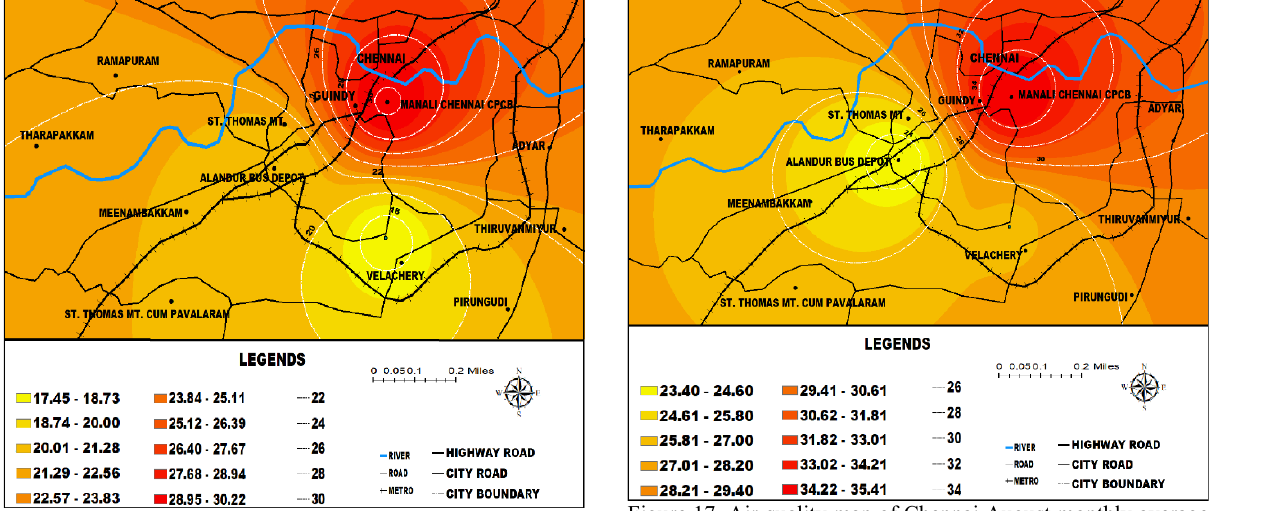
Figure 14. Air quality map of Chennai May monthly average based on NOx (µg/m 3 ).